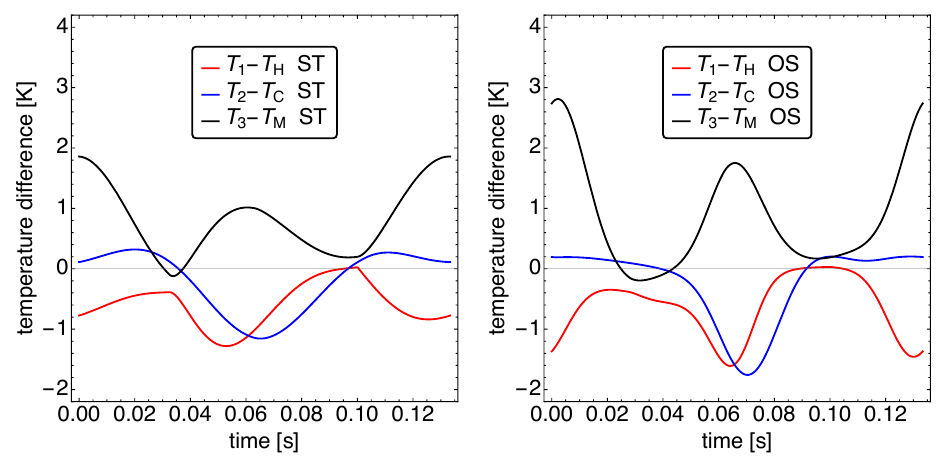
T T 1 , 2 , and 3 and the